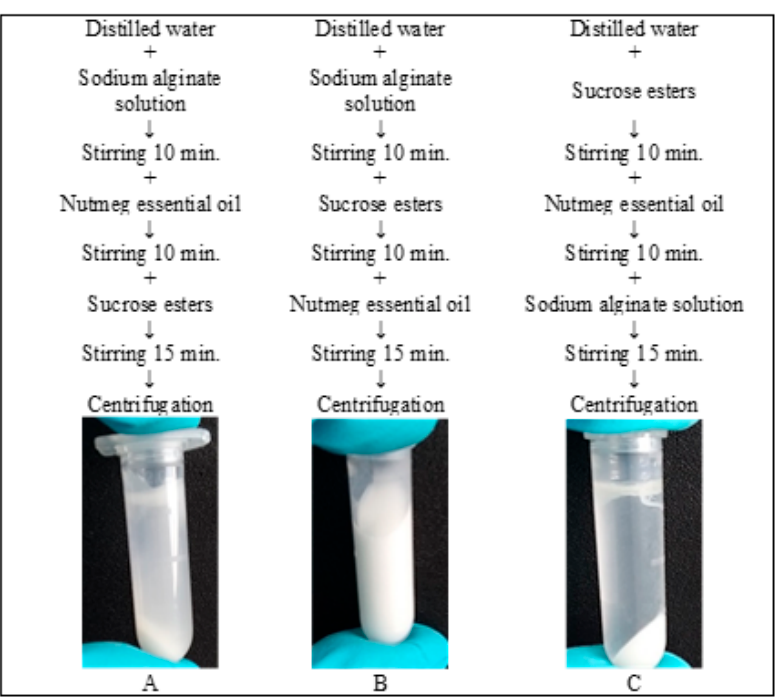
Figure 1. Three methods to produce emulsion with sucrose esters.